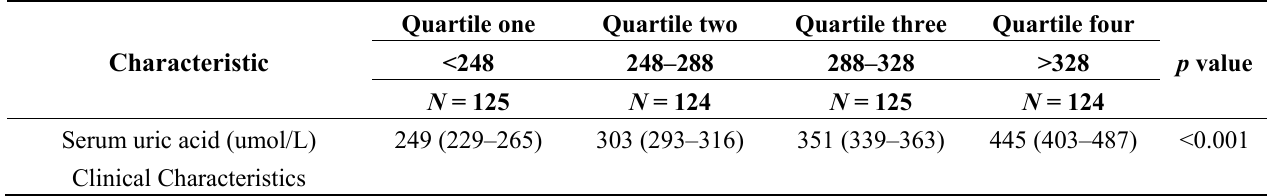
Table 2. Baseline characteristics of premenopausal